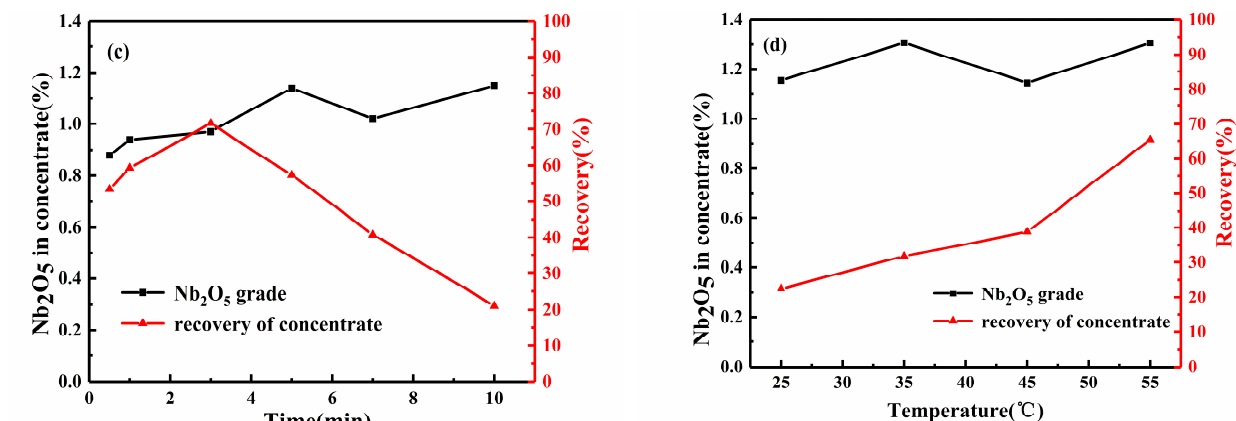
Figure 9. Experimental results of HOBA as a collector for Baiyun Obo niobium ore. ( a ) The Nb 2 O 5 grade and recovery of flotation concentrate as a function of pH (flotation conditions: 800 g/t collector dosage, room temperature, and the harvesting time of the collector is 3 min). ( b ) The Nb 2 O 5 grade and recovery of flotation concentrate as a function of the collector dosage (flotation conditions: 3.5 < pH < 4.5, room temperature, and the harvesting time of the collector is 3 min). ( c ) The Nb 2 O 5 grade and recovery of flotation concentrate as a function of the collector harvest time (flotation conditions: 3.5 < pH < 4.5, 1000 g/t collector dosage, and room temperature). ( d ) The Nb 2 O 5 grade and recovery of flotation concentrate as a function of slurry temperature (flotation conditions: 3.5 < pH < 4.5, 1000g/t collector dosage, and the harvesting time of the collector is 3 min).